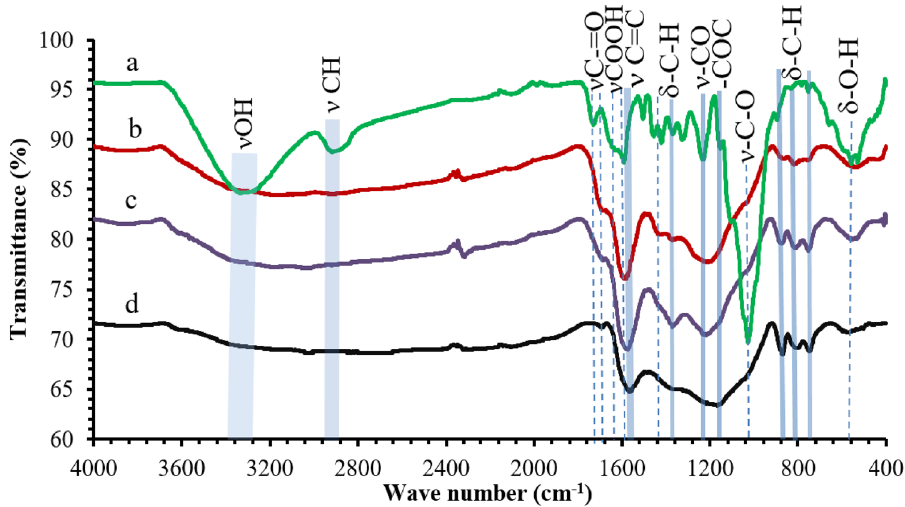
Figure 2. FT-IR transmission spectra of ( a ) dried raw eucalyptus wood chips, ( b ) eucalyptus wood chip activated carbon prepared at 500 °C, ( c ) eucalyptus wood chip activated carbon prepared at 600 °C, and ( d ) eucalyptus wood chip activated carbon prepared at 700